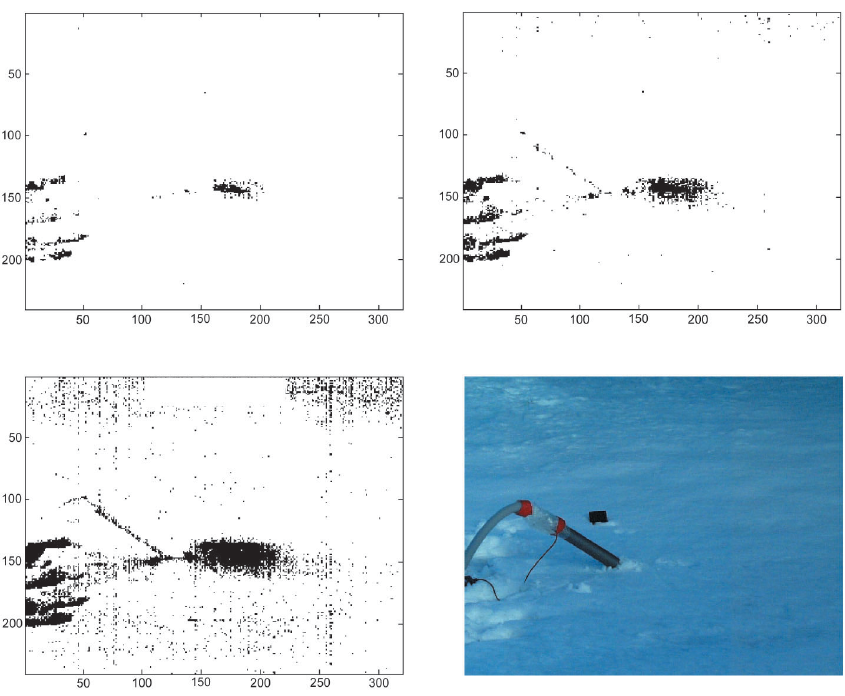
Fig. 10. Temperature difference ∆ T of the snow scene recorded at two different times on 20th February 2003, at 06:27 h and at 06:41 h. Threshold is ∆ T < 2 K; < 3 K; < 4 K; < 5 K from top left to bottom right. Several areas of low ∆ T detected. Colour photo of snow scene reveals mechanically undisturbed snow at gas outlet and com- pressed snow left of it (foot